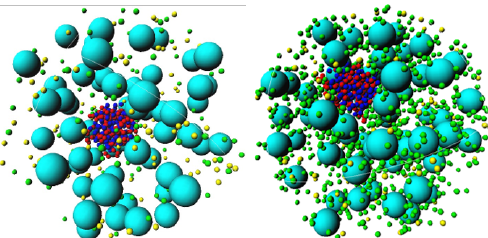
Figure 10. Representative snapshots showing the stability of the DNA (red)—H-NS (dark blue) complex upon the increase in the surface charge density of the crowding particles (light blue). ε pp = 2, Φ crow = 0.06 and σ crow is (left) 0, and (right) − 1.20 e /nm